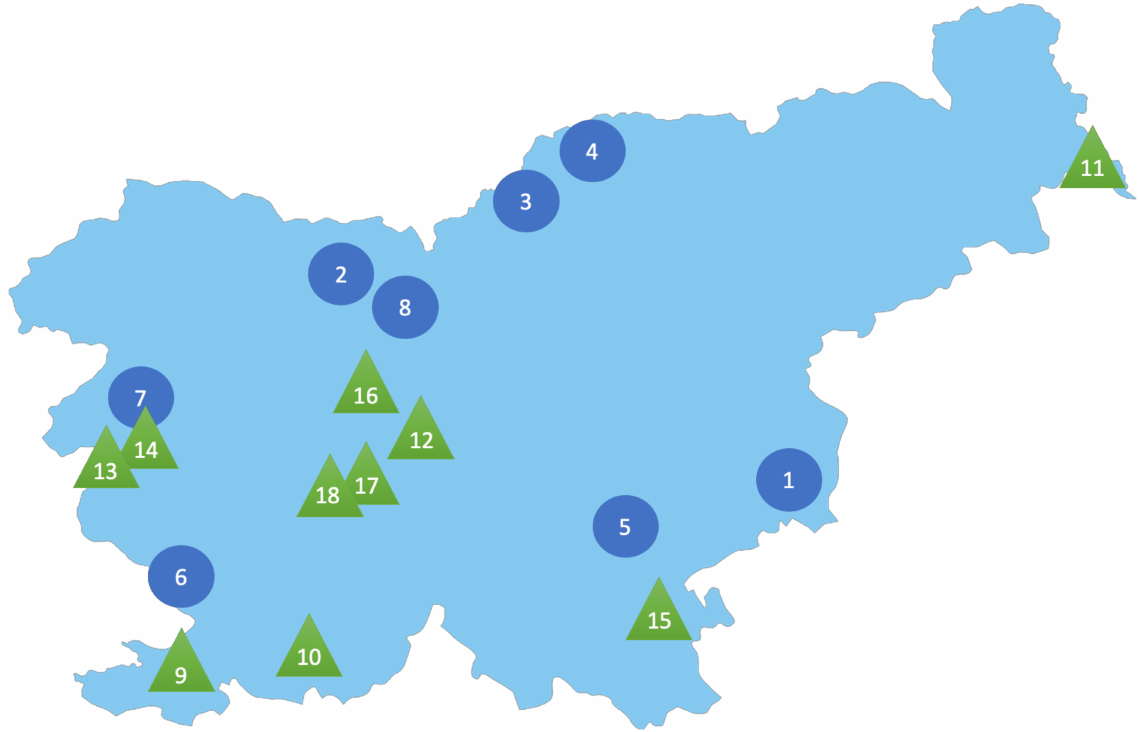
Figure 1. Map of locations where Tilia seed samples were collected. Tilia cordata samples are marked with circles and Tilia platyphyllos samples are marked with